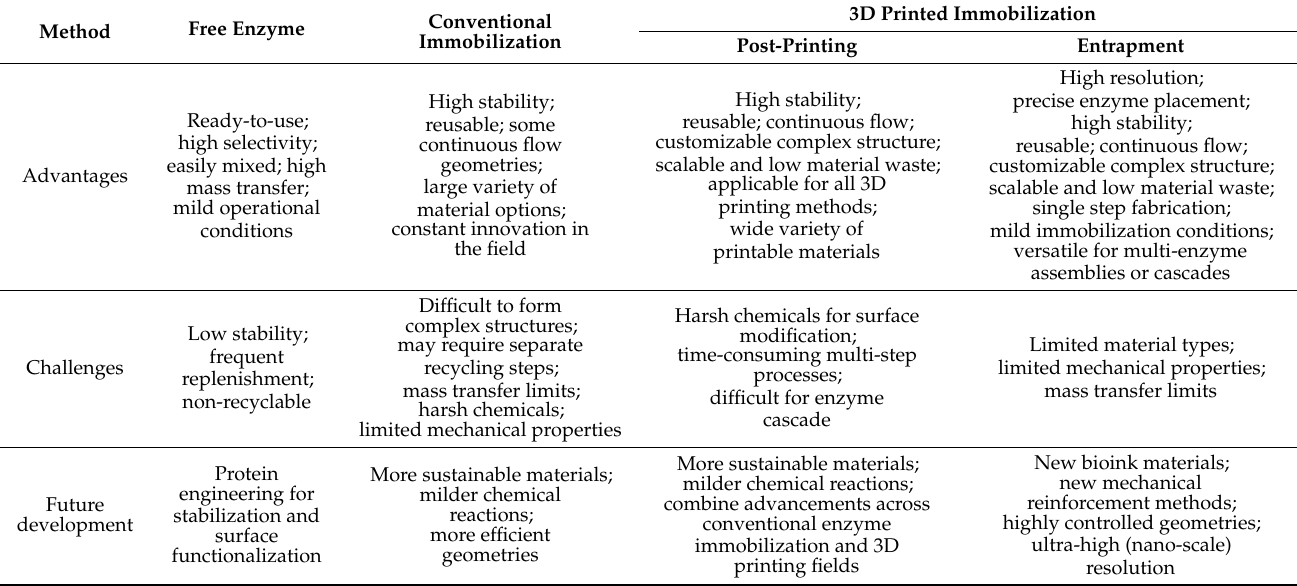
Table 1. Comparison of biocatalysts fabricated by different immobilization